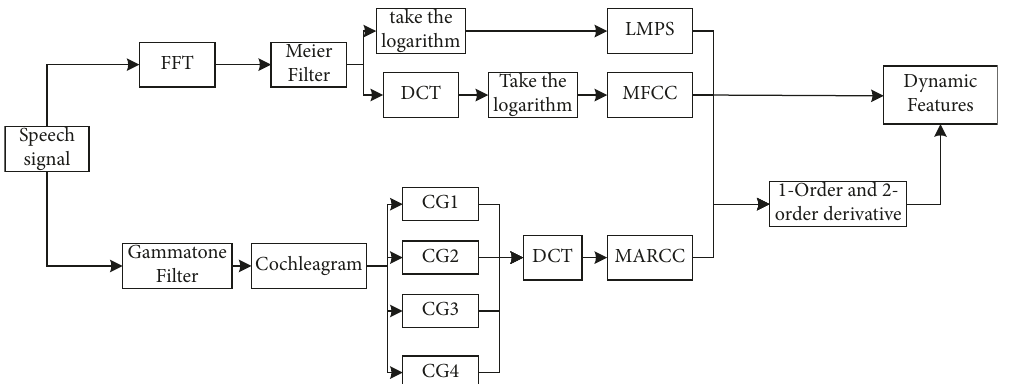
Figure 3: Block diagram of dynamic features